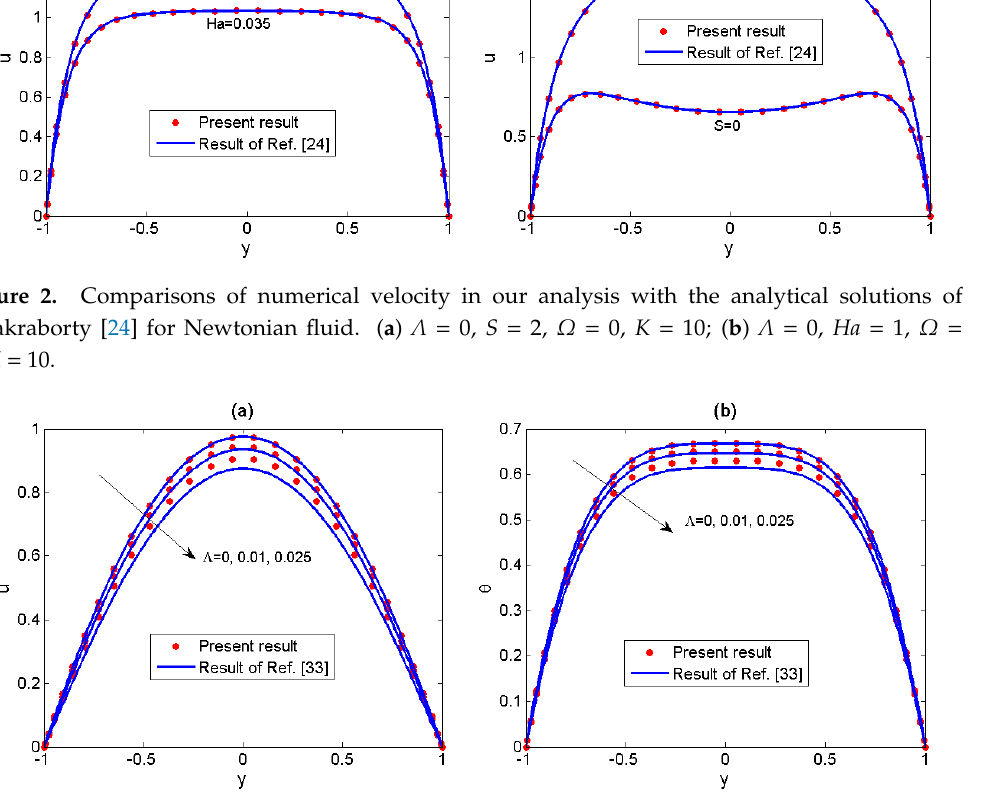
Figure 3. Comparisons of numerical velocity ( a ) and temperature ( b ) in our analysis with the approximate analytical solutions of Akgül [33] for different non-Newtonian parameters Λ ( S = 0, Ha ≈ 0, Ω = − 2, K = 10, Br = 2).